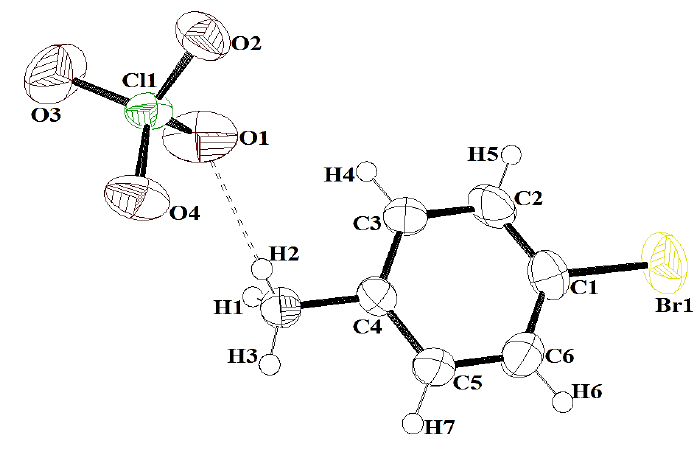
Figure 2. Ortep diagram of 4BAP (50% thermal ellipsoid).